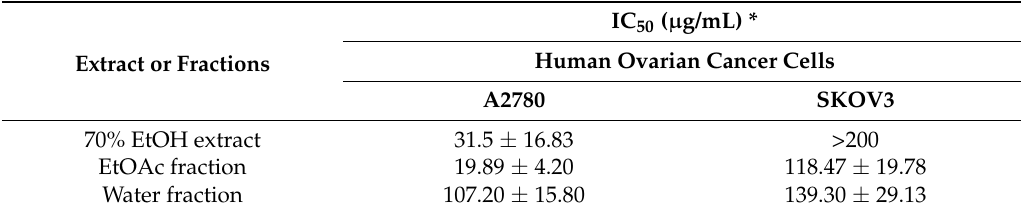
Table 1. Cytotoxicity of the 70% EtOH extract of A. sieboldii roots and its solvent fractions in human ovarian cancer cells A2780 and